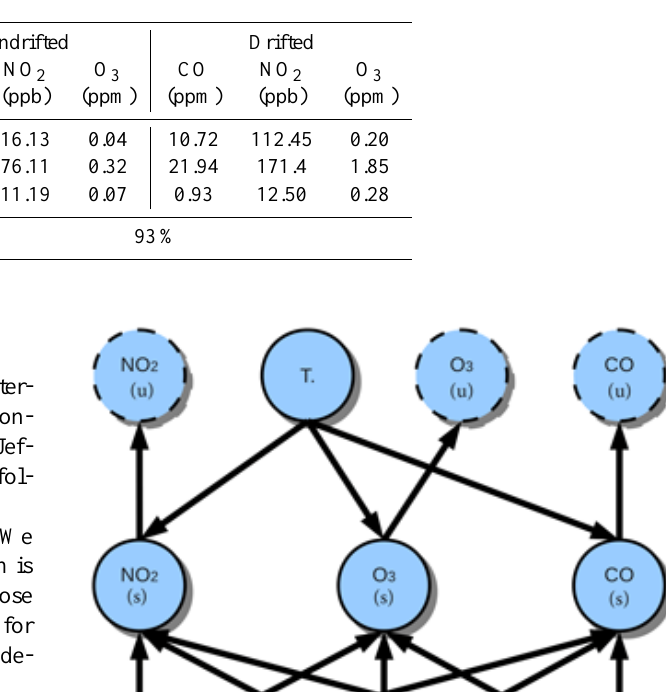
Table 2. The statistics of the original and drifted sensor readings.